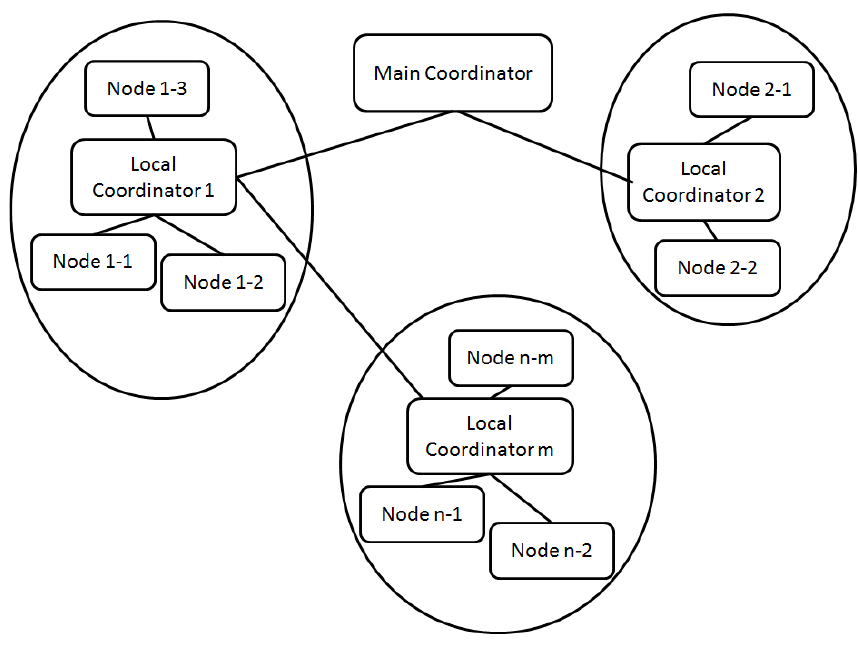
Figure 9. Network